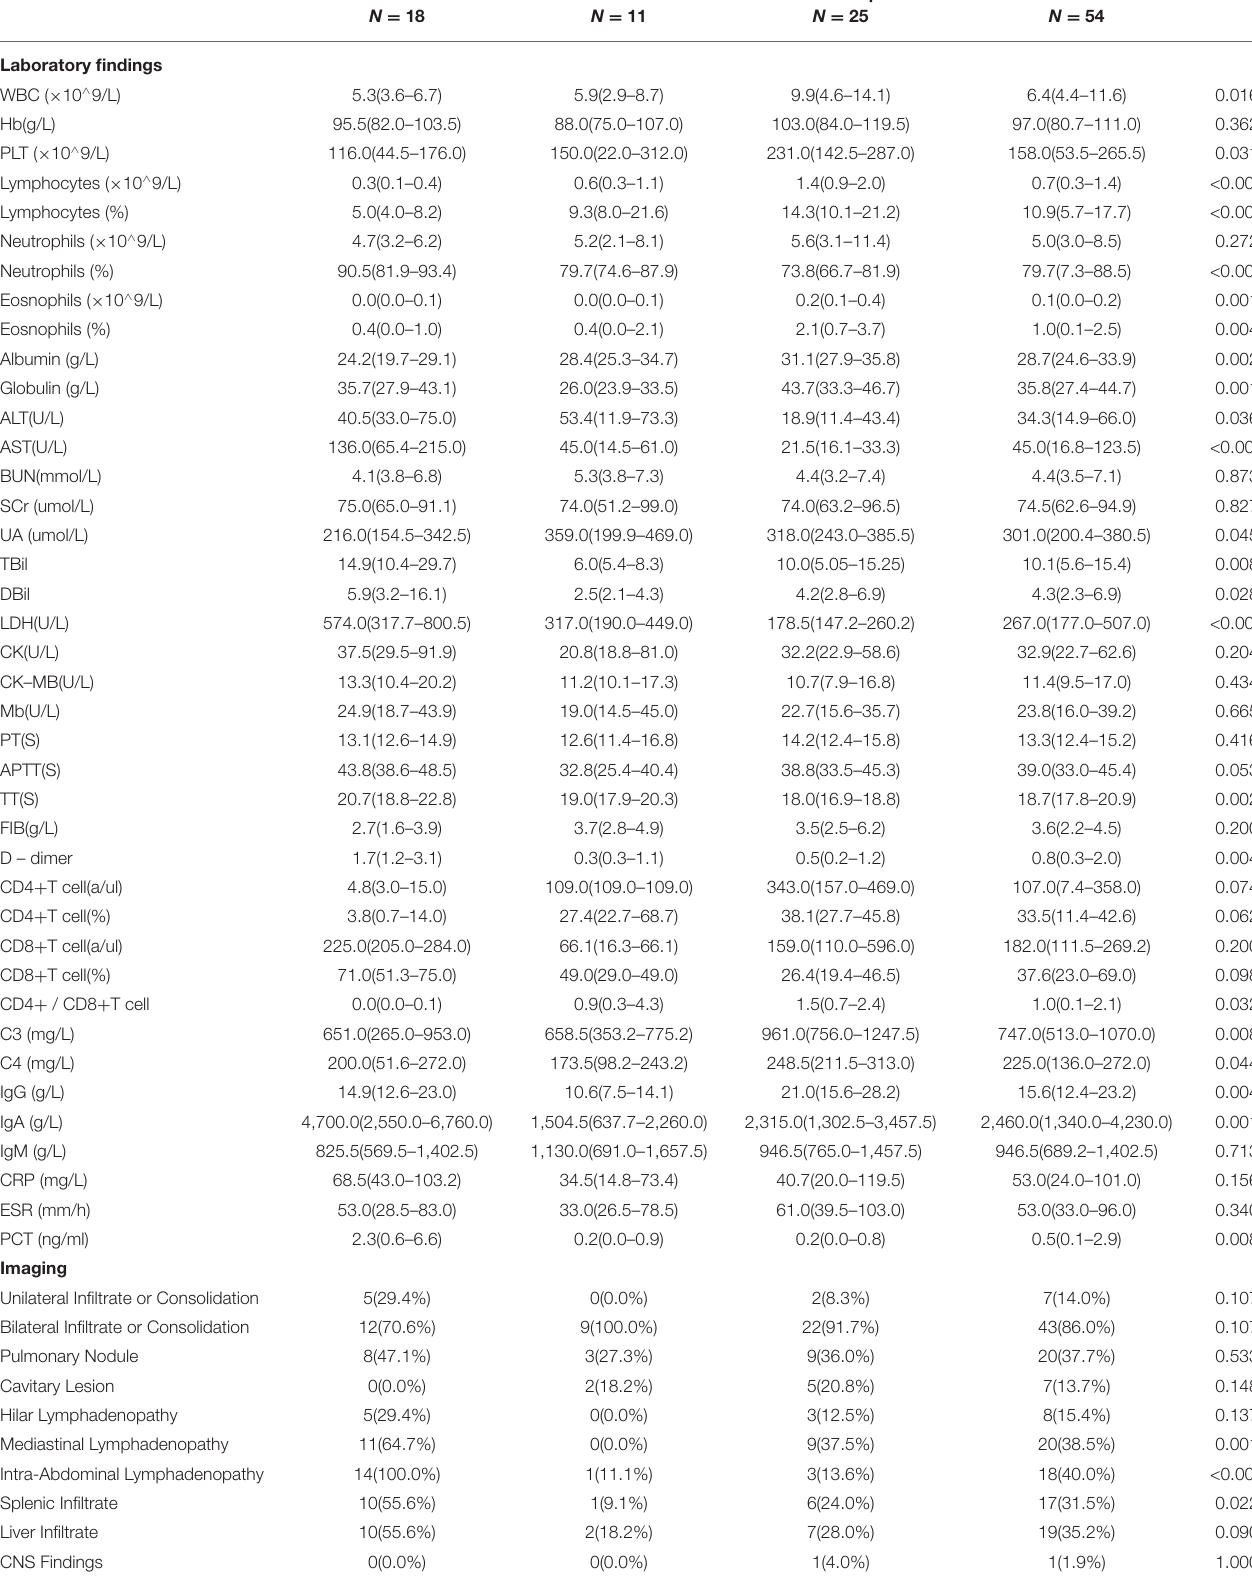
TABLE 2 | Laboratory findings and imaging in patients with TM infection among various immune